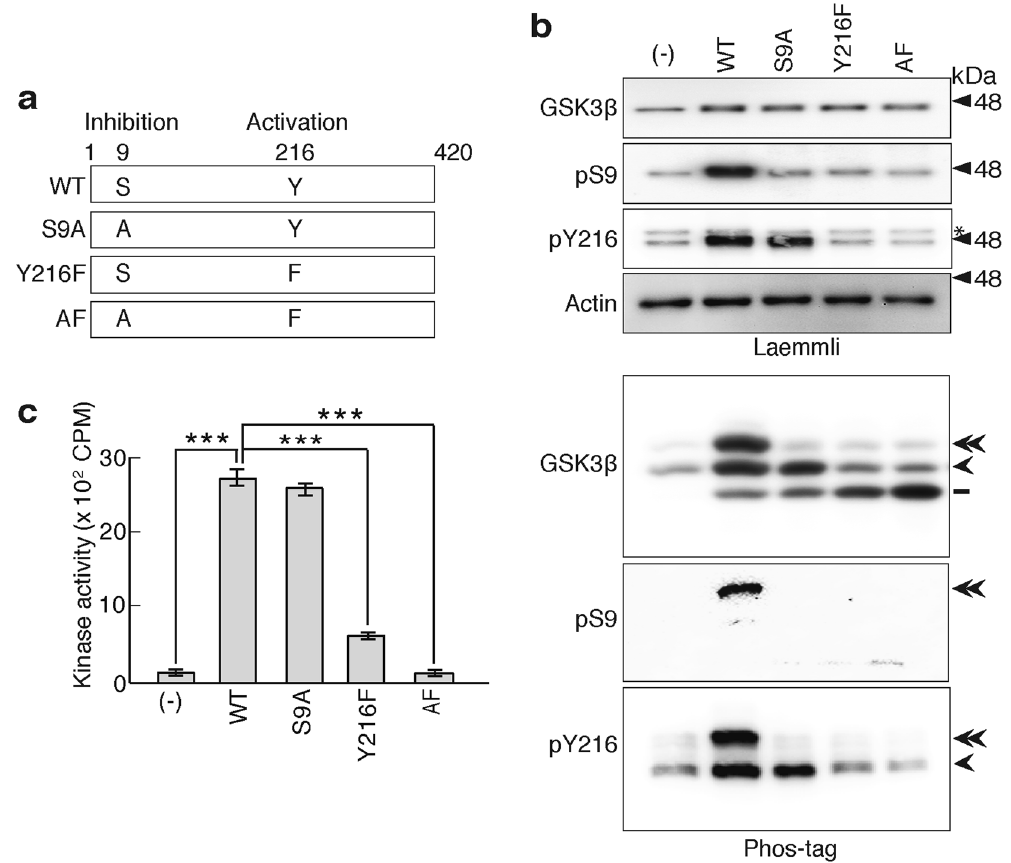
Figure 1. Separation of the three different phosphoisotypes of GSK3 β using Phos-tag SDS-PAGE. ( a ) Schematic representation of GSK3 β and its mutants at the Ser9 and Tyr216 phosphorylation sites. Ser9, whose phosphorylation inhibits the kinase activity, was mutated to Ala (S9A) and Tyr216, whose phosphorylation is required for the activity, was mutated to Phe (Y216F). GSK3 β with a double mutation is indicated by AF. ( b ) Separation of the three GSK3 β phosphoisotypes on Phos-tag SDS-PAGE. GSK3 β (WT) and its mutants at Ser9 (S9A), Tyr216 (Y216F), or both Ser9 and Tyr216 (AF) were expressed in CHO-K1 cells and subjected to Laemmli’s and Phos-tag SDS-PAGE, followed by immunoblotting with anti-GSK3 β , anti-phospho-Ser9 (pS9) and anti-phospho-Tyr216 (pY216) antibodies, as indicated. The left lane shows the control, untransfected cells (-). An asterisk in pY216 blot (third panel) indicates GSK3 α . A molecular weight marker of 48 kDa is indicated at the right side of the blots. Actin was used as the loading control in Laemmli’s SDS-PAGE. The amounts of exogenous GSK3 β on Phos-tag SDS-PAGE were adjusted prior by immunoblotting with anti-GSK3 β after Laemmli’s SDS-PAGE. The phosphorylation states of the three bands of GSK3 β on Phos-tag SDS-PAGE are indicated on the right side of the blot; the double arrowhead indicates GSK3 β that is phosphorylated at both Ser9 and Tyr216, the arrowhead indicates GSK3 β that is phosphorylated at Tyr216, and the bar indicates nonphosphorylated GSK3 β . ( c ) Kinase activity of GSK3 β and its mutants. The kinase activity was measured with immunoprecipitated GSK3 β and its mutants using a GSK3 β substrate peptide and [ γ - 32 P]ATP (means ± s.e.m. n = 3, the data from one of two independent experiments, *** p < 0.001, one-way ANOVA). Uncropped immunoblots of GSK3 β , pS9 and pY216 after Laemmli’s and Phos-tag SDS-PAGE are provided in Supplementary Fig.